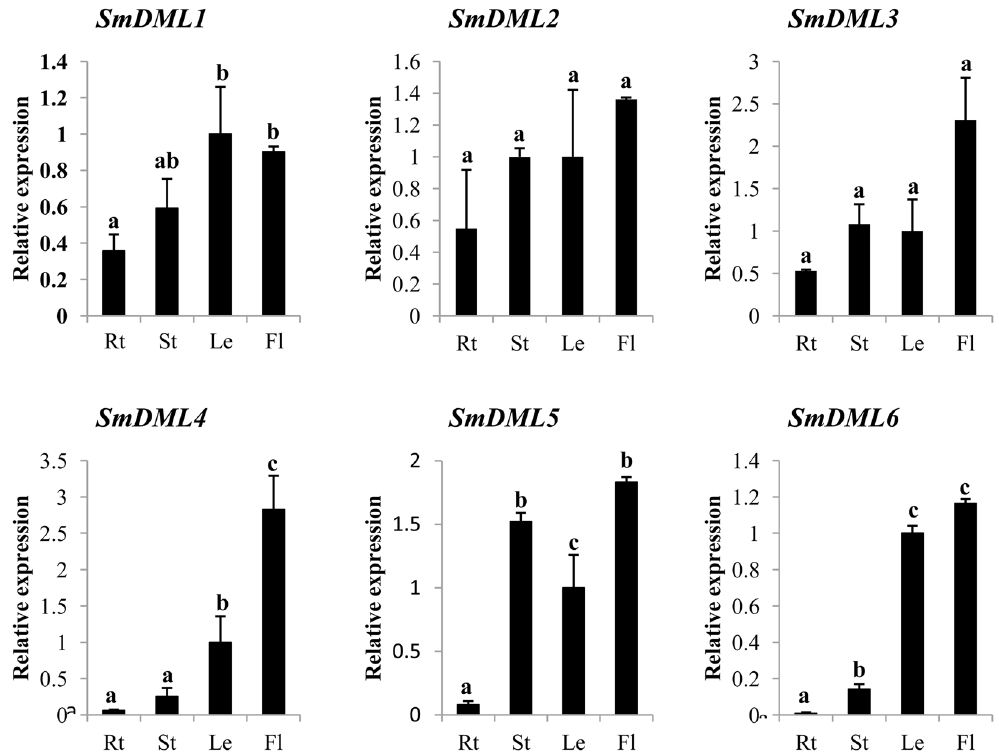
Figure 5. Expression patterns of SmDMLs in roots (Rt), stems (St), leaves (Le) and flowers (Fl) of S . miltiorrhiza . The expression levels were analyzed using the quantitative RT-PCR method. Fold changes of SmDML expression are shown. Expression level in leaves was arbitrarily set to 1 and the levels in other organs were given relative to this. One-way ANOVA was calculated using IBM SPSS 20 software. P < 0.05 was considered statistically significant and was represented by different letters. Error bars was indicated by the standard deviations of three biological